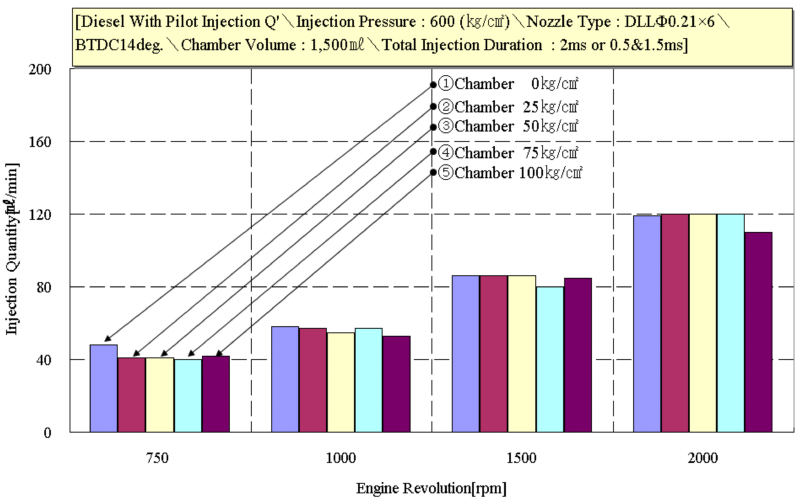
Figure 15. Injection Quantity on Engine Revolution with Pilot Injection of Diesel Fuel.